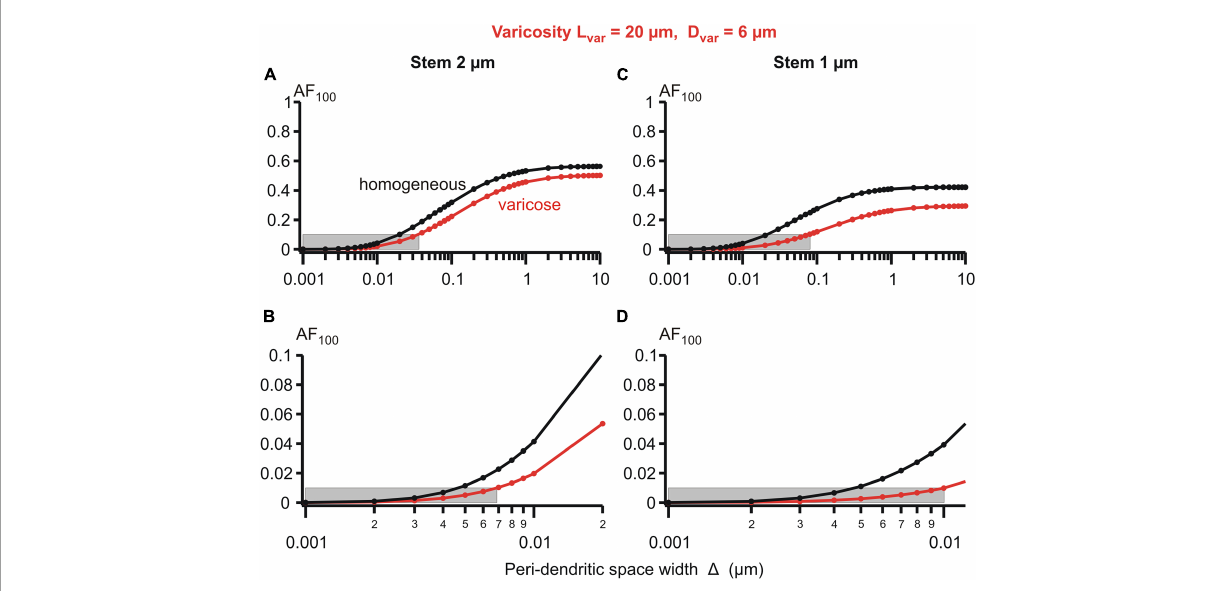
FIGURE6 Attenuation factor AF 100 (ordinate, dimensionless) in function width/thickness (cid:49) (logarithmic abscissa, µ m) of the peri-dendritic layer of the interstitial conductive fluid between heterogeneous dendrite and adjacent glial cells. Bottom plots are fragments of top plots. Dendrite of stem diameter 2 (left) or 1 µ m (right) without (black plots) or with (red plots) varicosity of a fixed size (length 20 µ m, diameter 6 µ m) located in 100 µ m from the dendrite origin. Grey boxes indicate 0.1 (A,C) and 0.01 (B,D) levels of AF 100 .